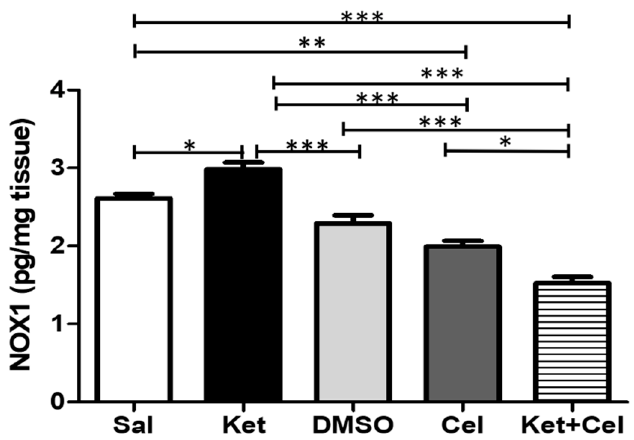
Figure 5. Celastrol administration in postnatal life decreased NOX1 levels in the cerebellum of adult mice. NOX1 levels (pg / mg tissue) in the cerebellum of adult mice receiving saline (Sal, n = 3) or ketamine (Ket, n = 5) or a 50% DMSO in PBS (DMSO, n = 3) or celastrol (Cel, n = 3) or ketamine + celastrol (Ket + Cel, n = 5) at PNDs 7, 9 and 11. One Way ANOVA, followed by Tukey’s post hoc test F = 50.30, * p < 0.05; ** p < 0.01; *** p < 0.001.